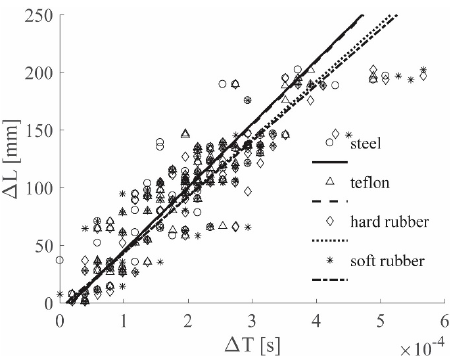
Figure 10. ( Δ L – Δ T ) visual approach results for ACC sensors, Al plate, all tips, filtered with the 0–8000 Hz filter.